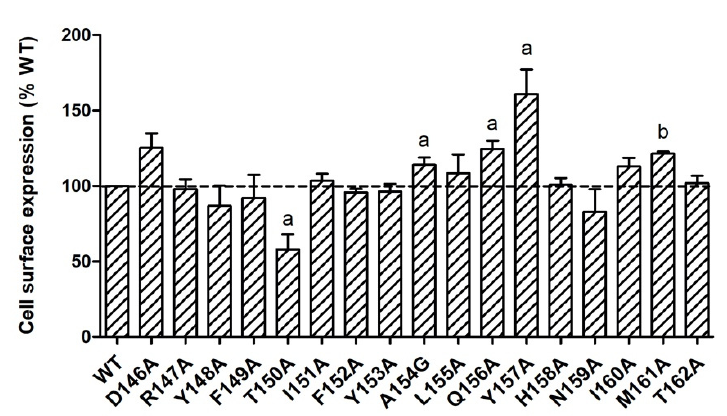
Figure 2. Cell surface expression of WT and mutant MC4Rs by flow cytometry. HEK293T cells were transiently transfected with WT and mutant MC4Rs. Fluorescence of Alexa Fluor 488 at non-permeabilized cells was measured. Results are expressed as % cell surface expression level of WT MC4R. Values are mean ± standard error of the mean (S.E.M.) of at least three independent experiments. The significant difference between WT and mutant: a, p < 0.05; b, p < 0.001.